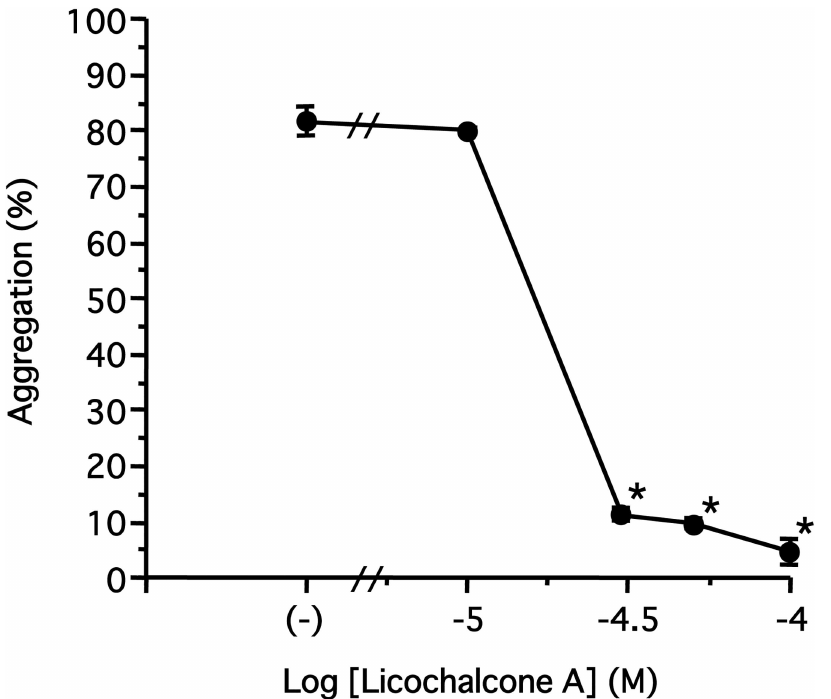
Fig 4. Concentration-dependent inhibition of collagen-induced human platelet aggregation by licochalcone A. Licochalcone A (10–100 μ M) or DMSO (control) were preincubated for 5 min before addition of collagen(5 μ g/ml) in the presenceof 1 mM CaCl 2 . Results are shown as mean ± S.E.M. ( * P < 0.05compared with control, n = 3, Dunnett’smethod).